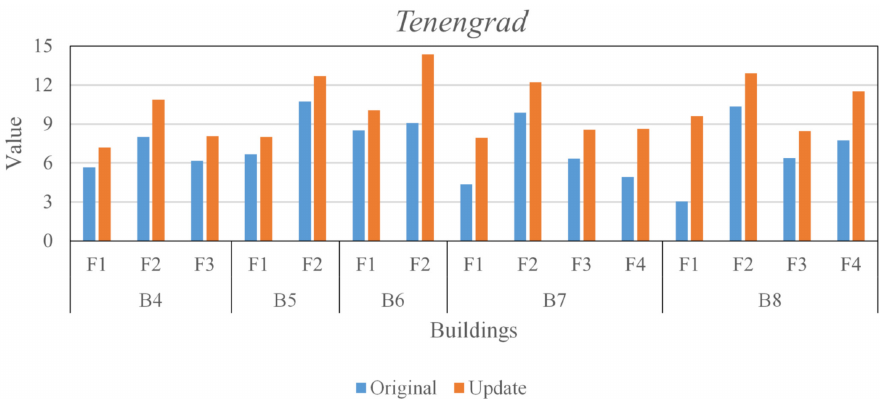
Figure 10. Comparisons of Ten values calculated from the textures on the façades of five building models in Figure 8a–e. Dark blue and orange columns denote the textures before and after optimiza- tion, respectively. B4–B8 indicate the number of building models, and F1–F4 indicate the façades of building